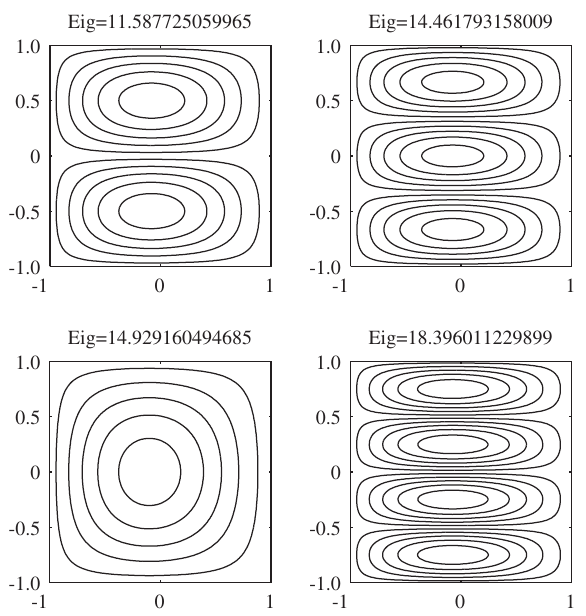
illustrates the fi rst four buckling modes of a plate with a different boundary condition. For these fi gures, a 17 2 points Table 2 , results are compared with exact solutions by Khdeir and Librescu [38] , differential quadrature results by Liew and Huang [5] based on the FSDT, and Ferreira et al. [37] based on the FSDT and using a meshless technique and 21 2 points.